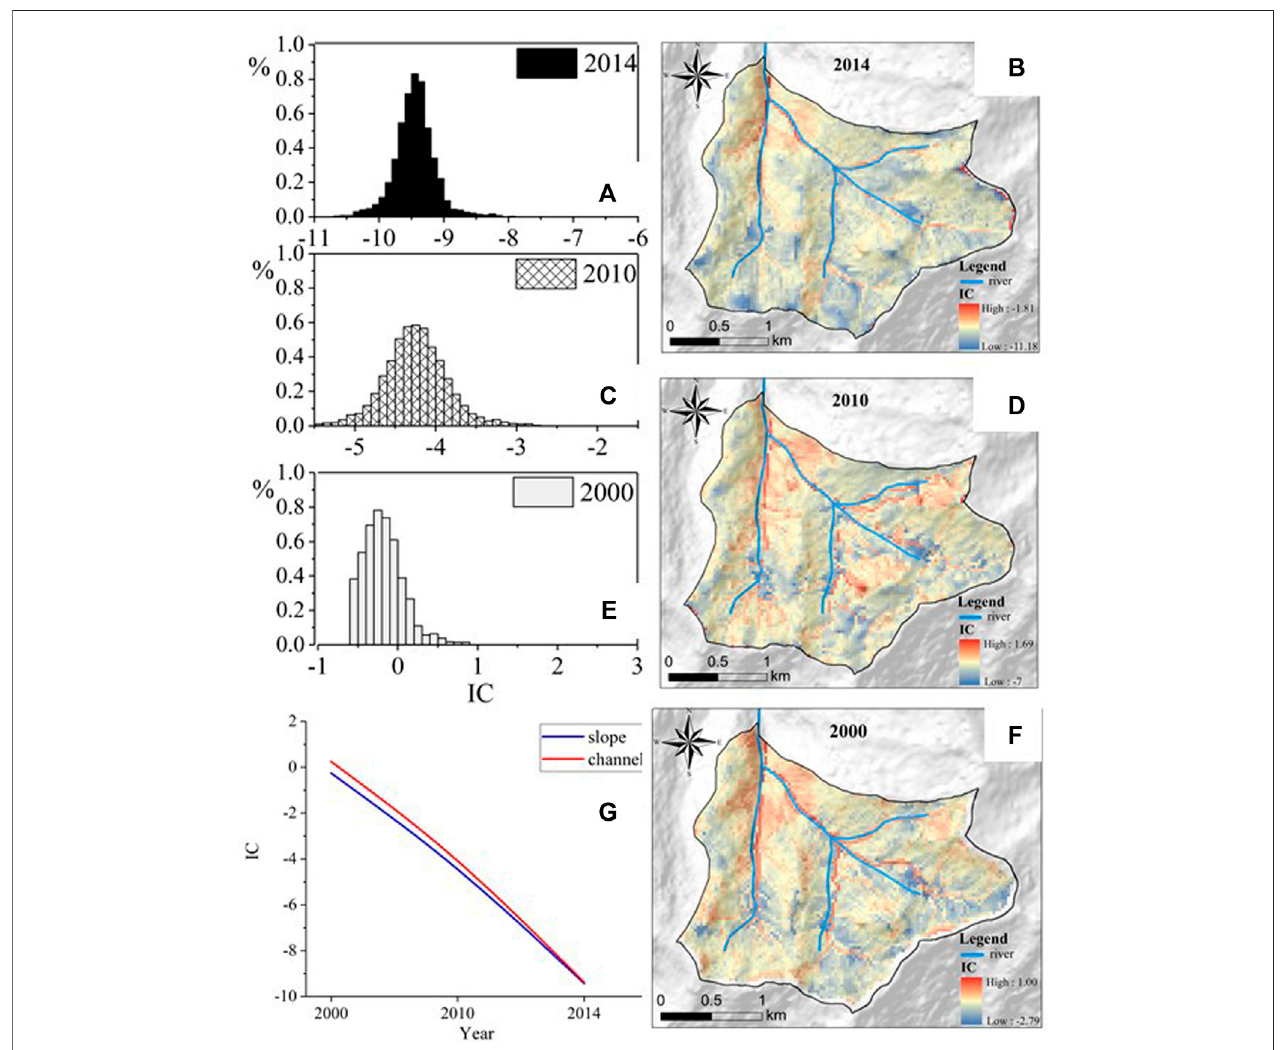
FIGURE 12 | Distribution of the IC values in tributary 9 near the